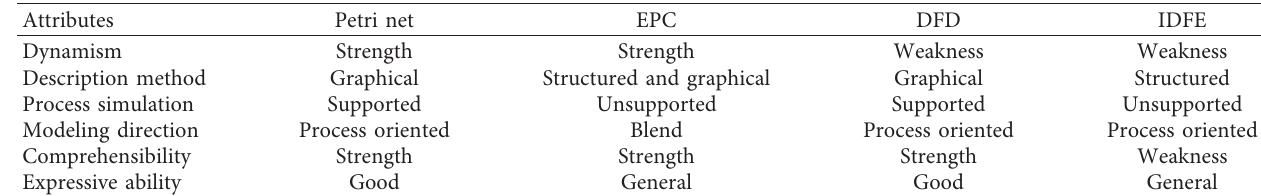
Table 2: Comparison of process modeling